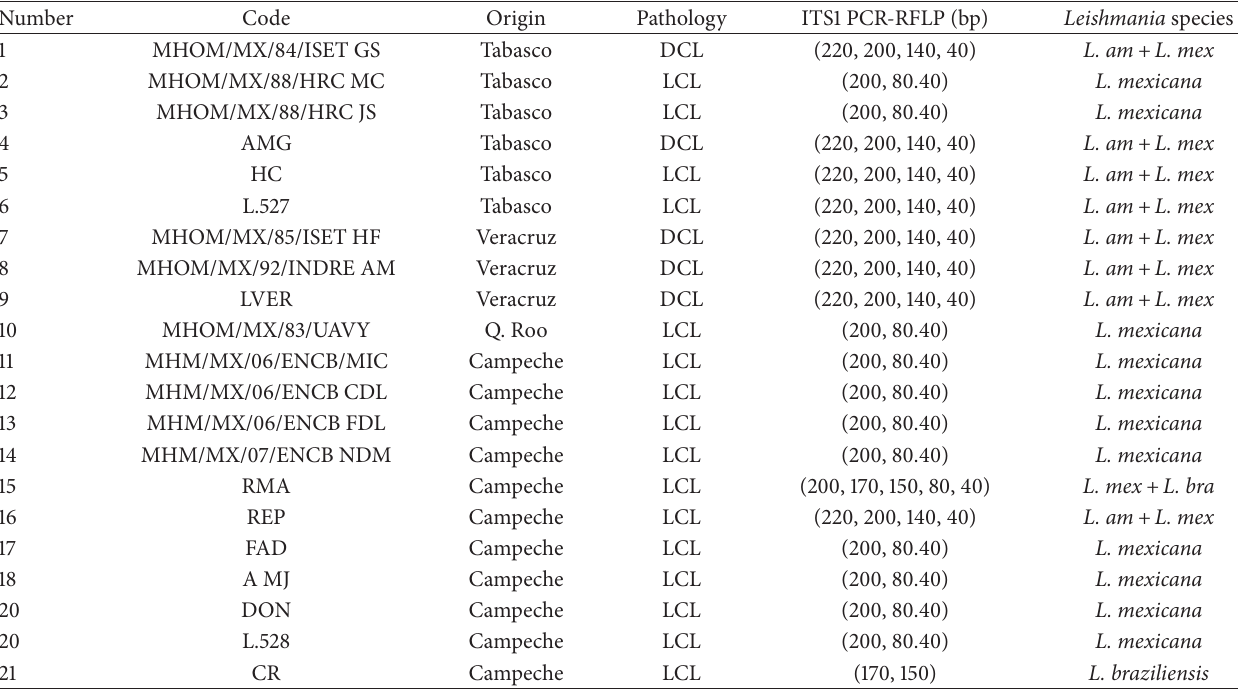
of Mexican Leishmania species, where they identified in clinical samples both DNA from L. (L.) mexicana and